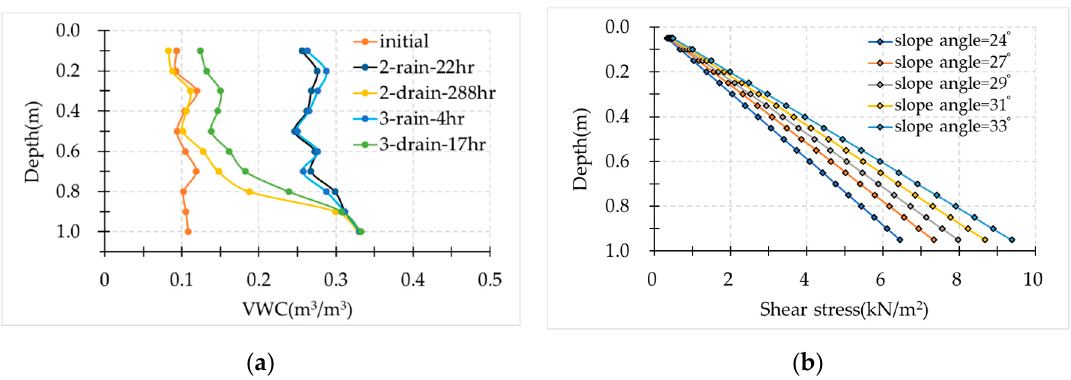
Figure 11. Test conditions. ( a ) Soil moisture distribution with depth after the rainfall and drain events; ( b ) shear stress with a depth corresponding to the slope angle.